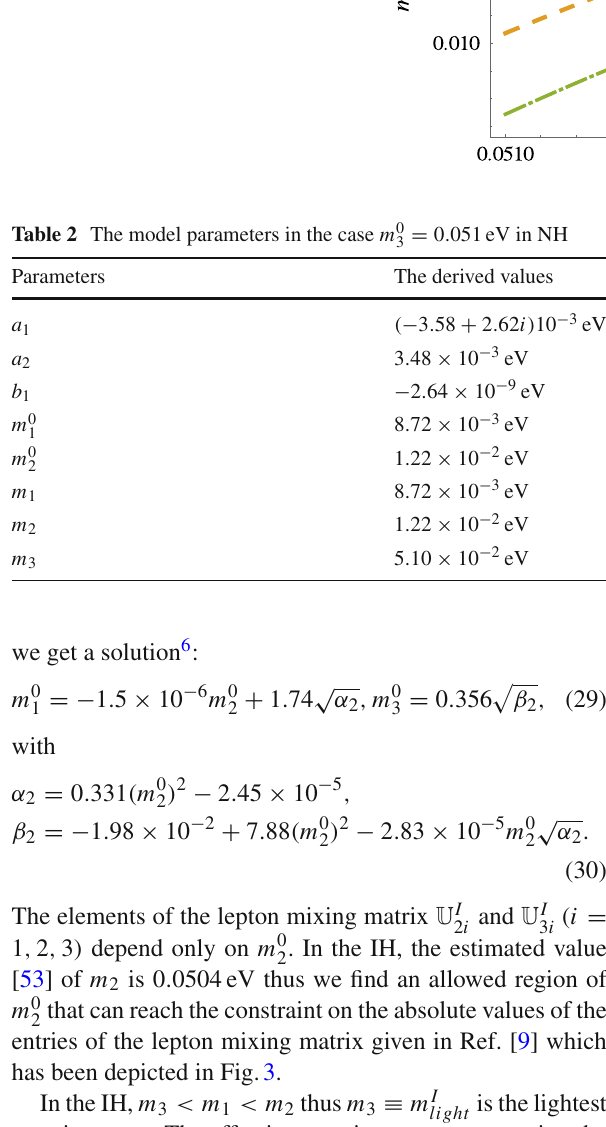
Fig. 2 (cid:2) m ee (cid:3) , m β and m N functions of m 0 NH